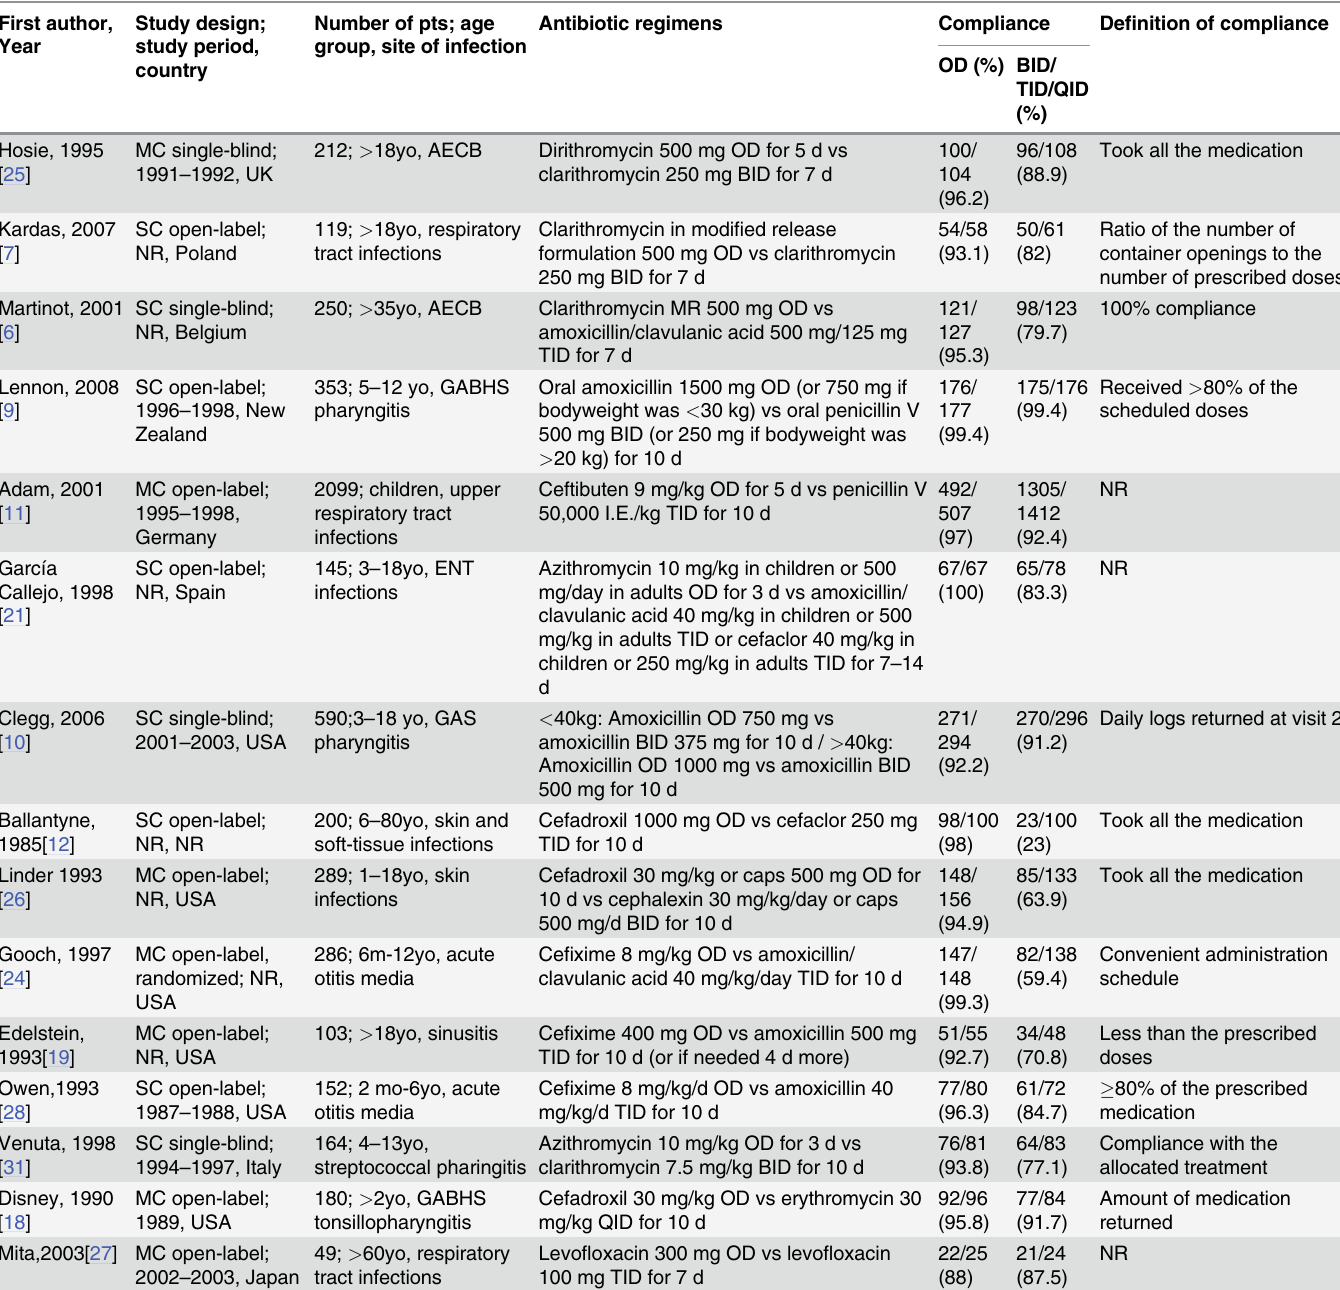
Table 1. Characteristics and outcomes of the studies comparing compliance with once versus twice/thrice/four times daily antibiotic